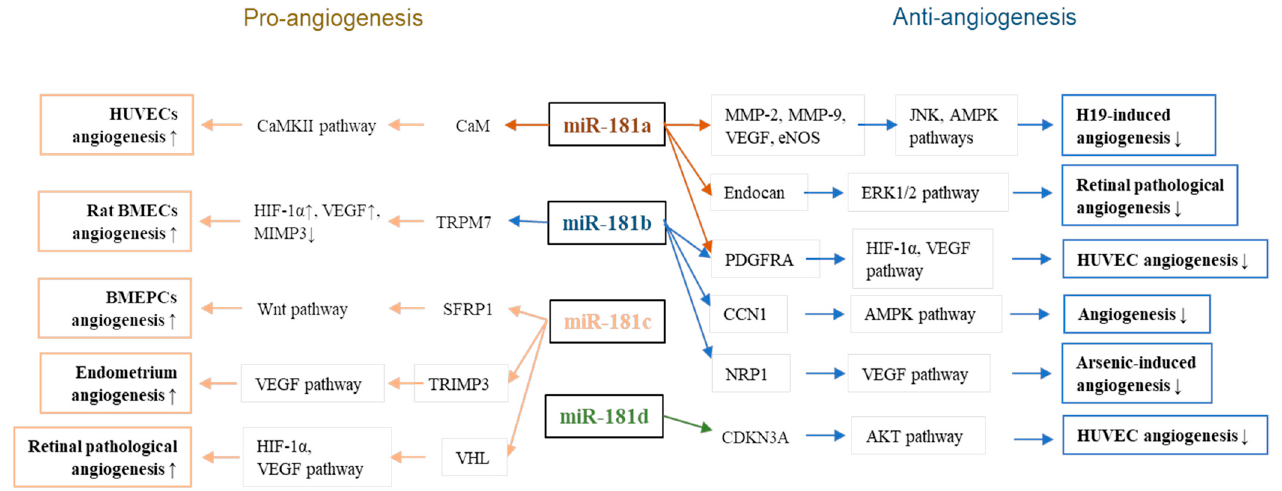
Figure 1. Roles of miR-181 family members in endothelial cell angiogenesis. Table 2. The pathophysiological role of miR-181 in EC angiogenesis.